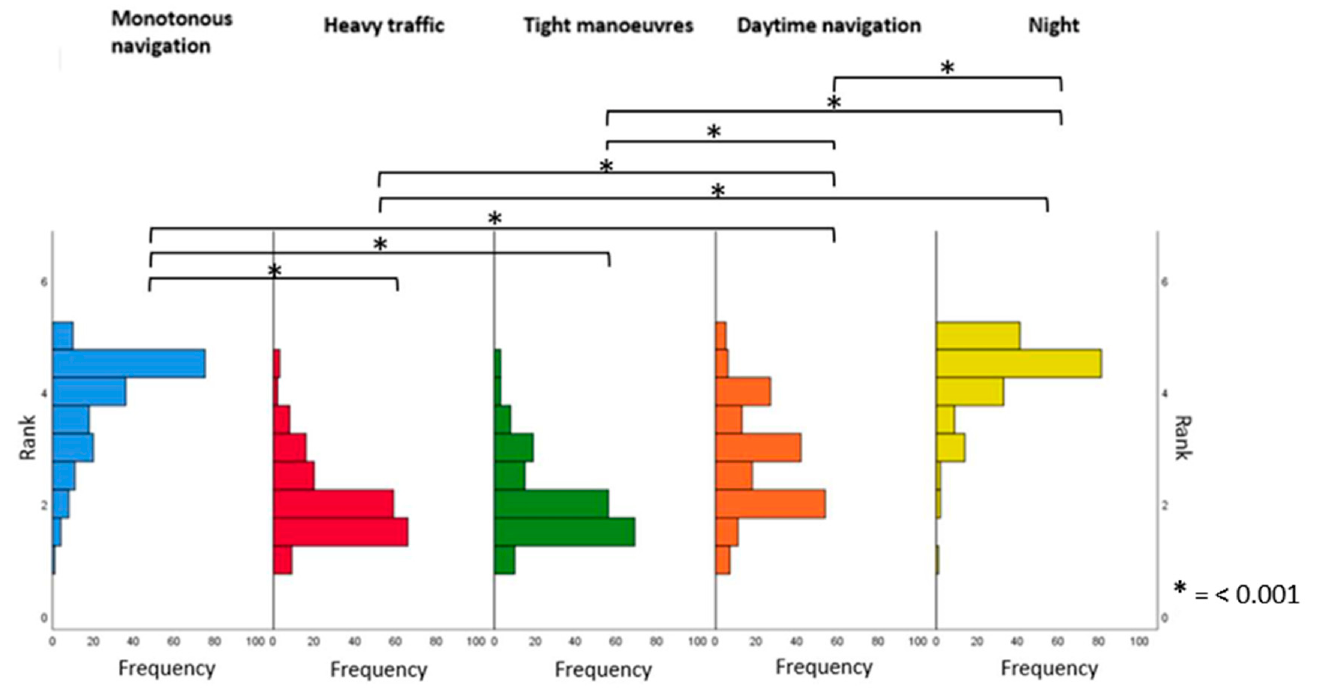
Figure 1. Frequency of sleepiness as a function of navigation condition.